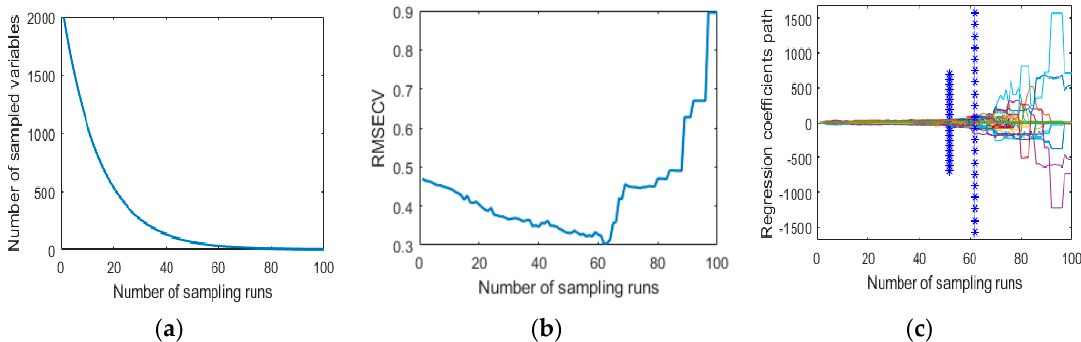
Figure 5. ( a ) Change in the number of selected variables with the change in the number of samples runs for the CARS algorithm in Daye. ( b ) Change in the 10-fold root-mean-square error of cross-validation value with the change in the number of sample runs for the CARS algorithm in Daye. ( c ) Change in the regression coefficient variable with the change in the number of samples runs for the CARS algorithm in Daye.